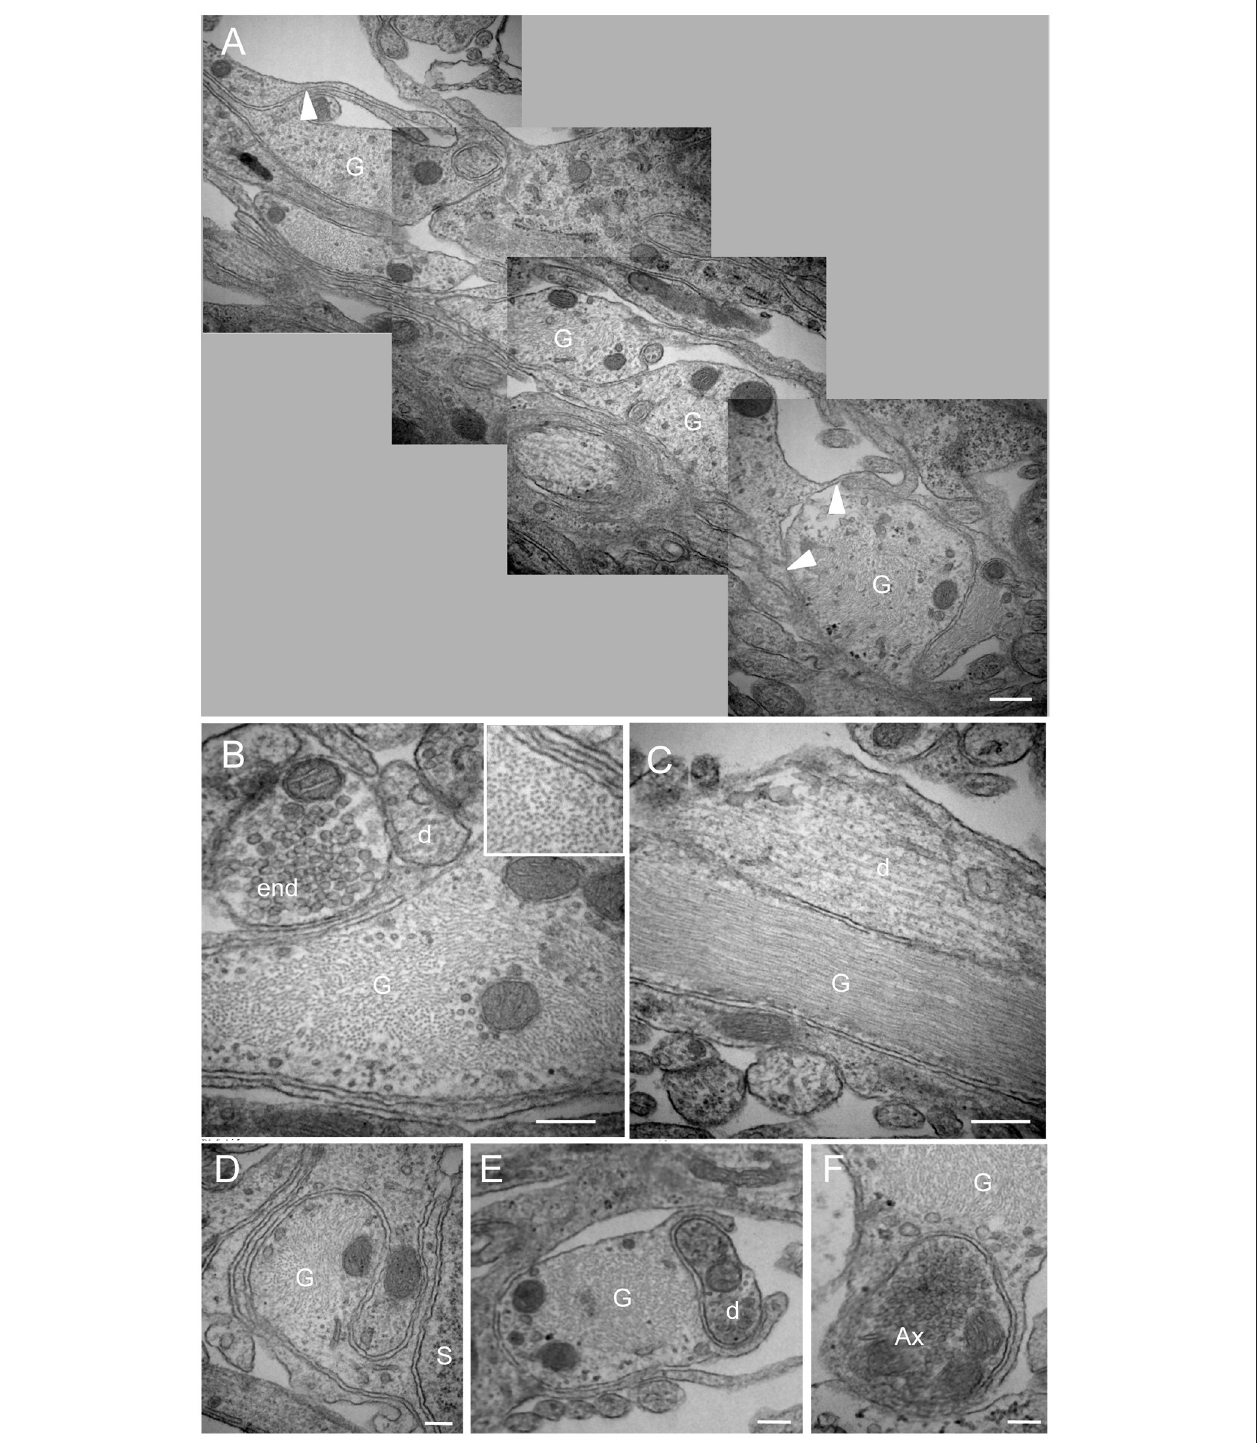
FIGURE 4 | Morphological organization of the NTS/AP border. (A) Electron micrographs performed on sagital dorsal vagal complex sections showing the presence of rounded, fibrous glial processes at the border between the area postrema (AP) and nucleus tractus solitarius (NTS). Note that these fibrous processes create a continuous layer between the AP and the NTS. Small ramifications (arrowheads) of the rounded processes could be observed. (B,C) These glial processes could be identified by their numerous cytoskeleton filaments visible on sagital (B) and horizontal (C) sections. Inset in (B) Illustration of the high cytoskeleton filaments density in rounded glial processes. (D–F) Close juxtapositions between fibrous glial processes and neuronal elements i.e., neuronal soma (D) , dendritic profile (E) and axon terminal (F) are noticeable. Scale bars: 500 µ m in A; 200 µ m in (B–F) . D, dendritic profiles; Ax, axon terminals; S, soma; G: glial process.